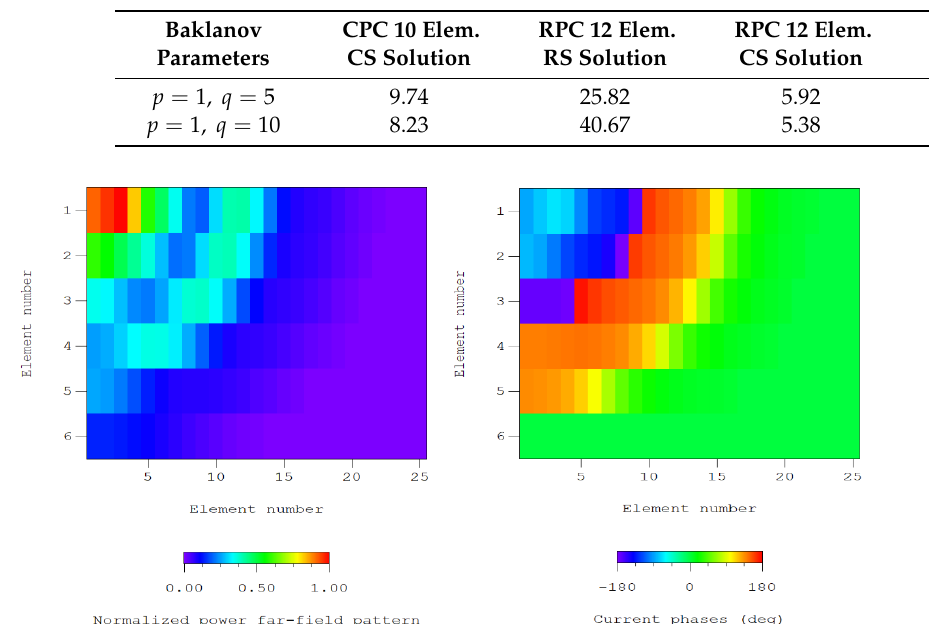
Table 10. Dynamic range ratio ( |𝐼 𝑚𝑎𝑥 |/|𝐼 𝑚𝑖𝑛 | ) of the current excitation amplitudes of the planar array generated by means of the generalisation of Tseng and Cheng method. Element currents with |𝐼 𝑚𝑛 |/|𝐼 𝑚𝑎𝑥 | > 10 −2 (weak excitations) have been deleted.